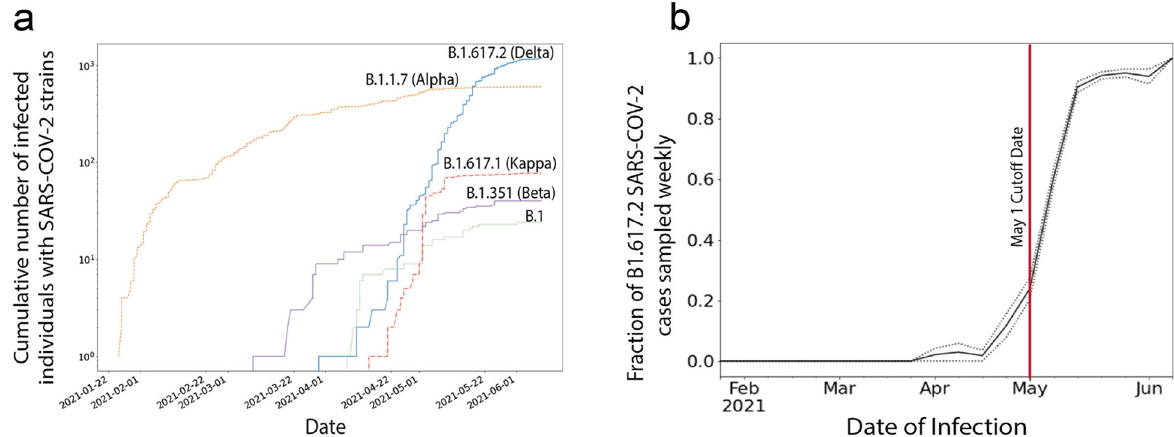
Figure 2. Various strains of SARS-Cov2 in Bahrain. ( a ) Cumulative counts of individuals infected with various strains of SARS-Cov2 in Bahrain. ( b ) Fraction of infections of Delta/B.1.617.2 (over all other variants detected) with +—one s.e. of the total fraction. Total counts of B.1.617.2 exceed other detections (note log scale). May 1 (red line) was selected as a cutoff date of when B.1.617.2 began to rise as the dominant strain in the